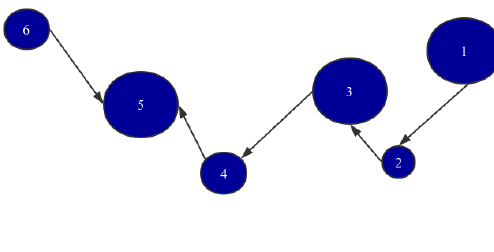
Fig. 4 The right line diagram of eye movement